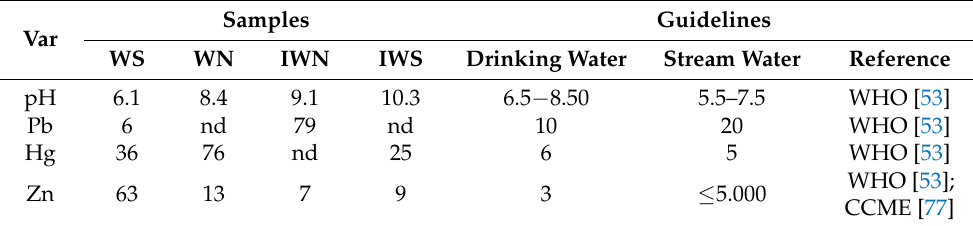
Table 4. Water samples’ pH, Pb, Hg, and Zn concentrations and reference values (in μ g/L).